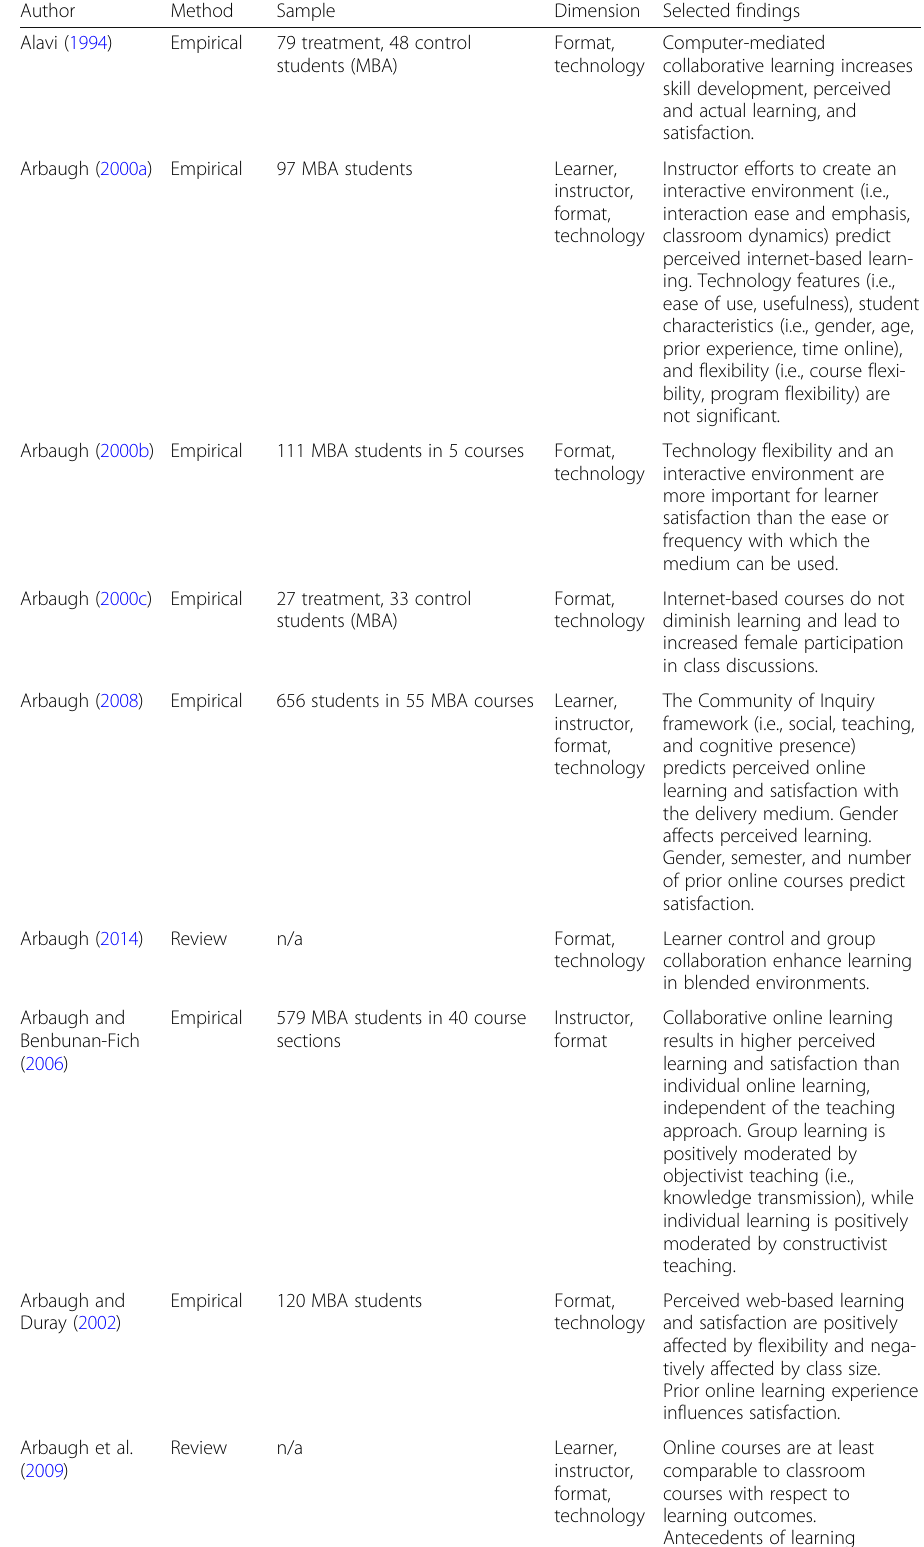
Table 1 Overview of Findings from the Extant